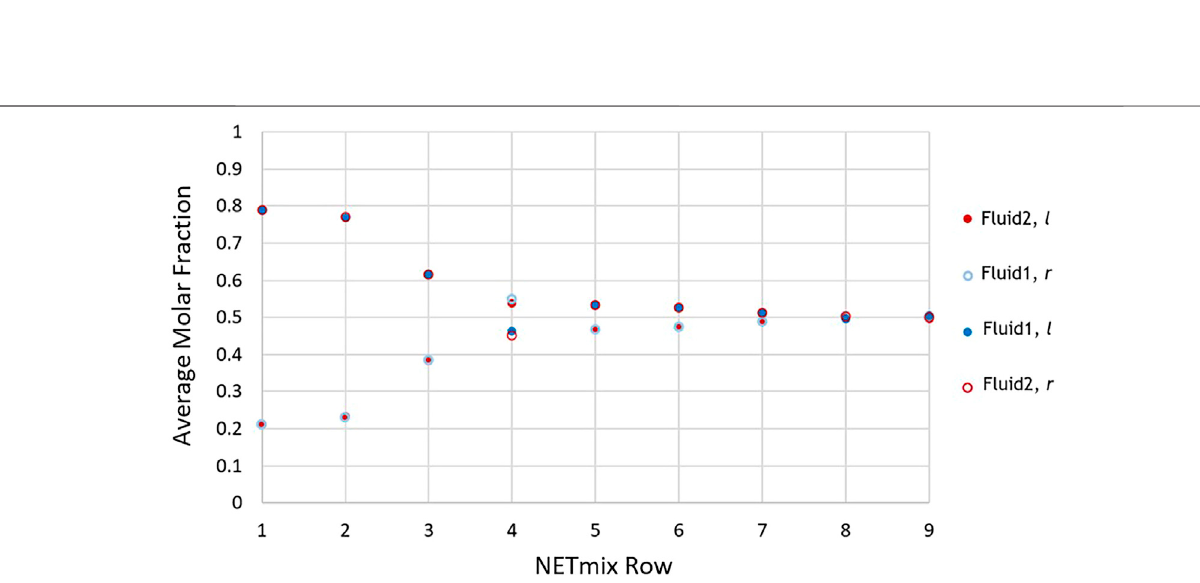
l b /Fluid1, left